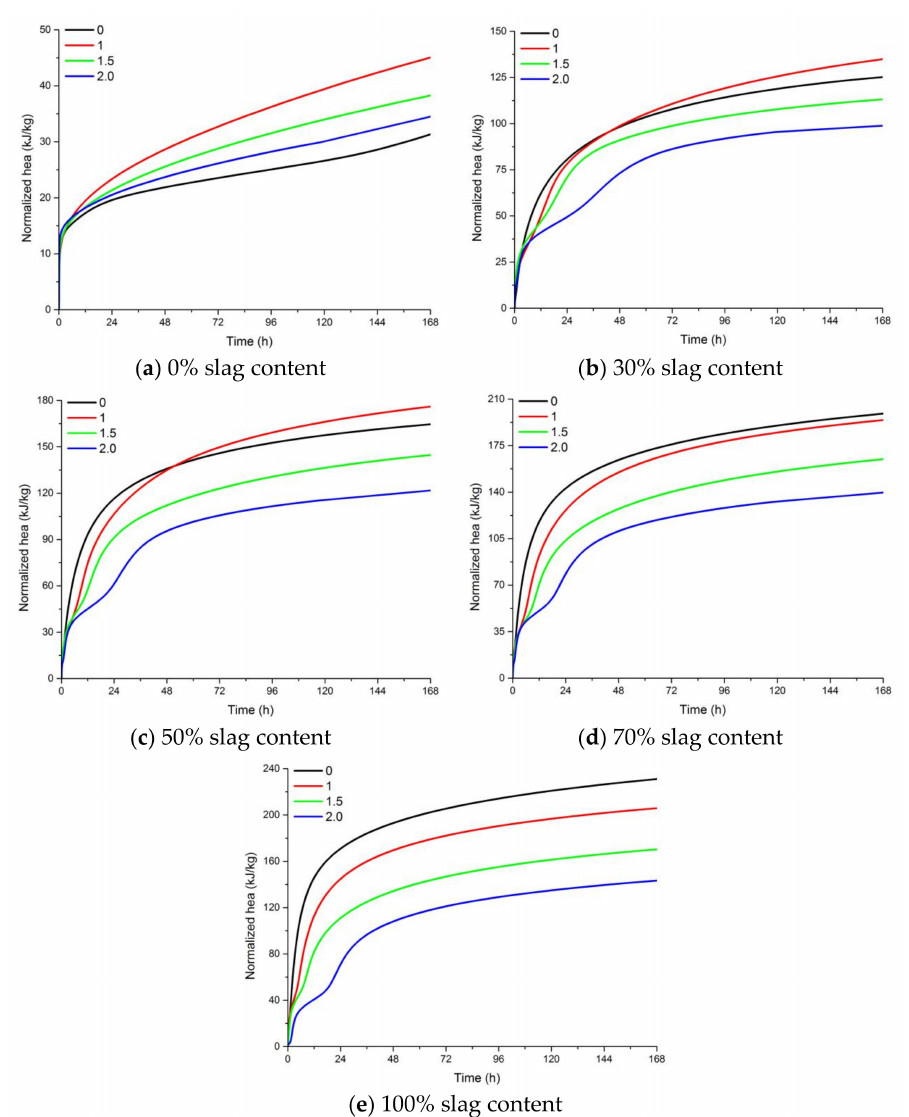
Figure 7. The e ff ect of the activator modulus and slag content on the cumulative heat release of AAFS. ( a ) 0% slag content; ( b ) 30% slag content; ( c ) 50% slag content; ( d ) 70% slag content; ( e ) 100% slag